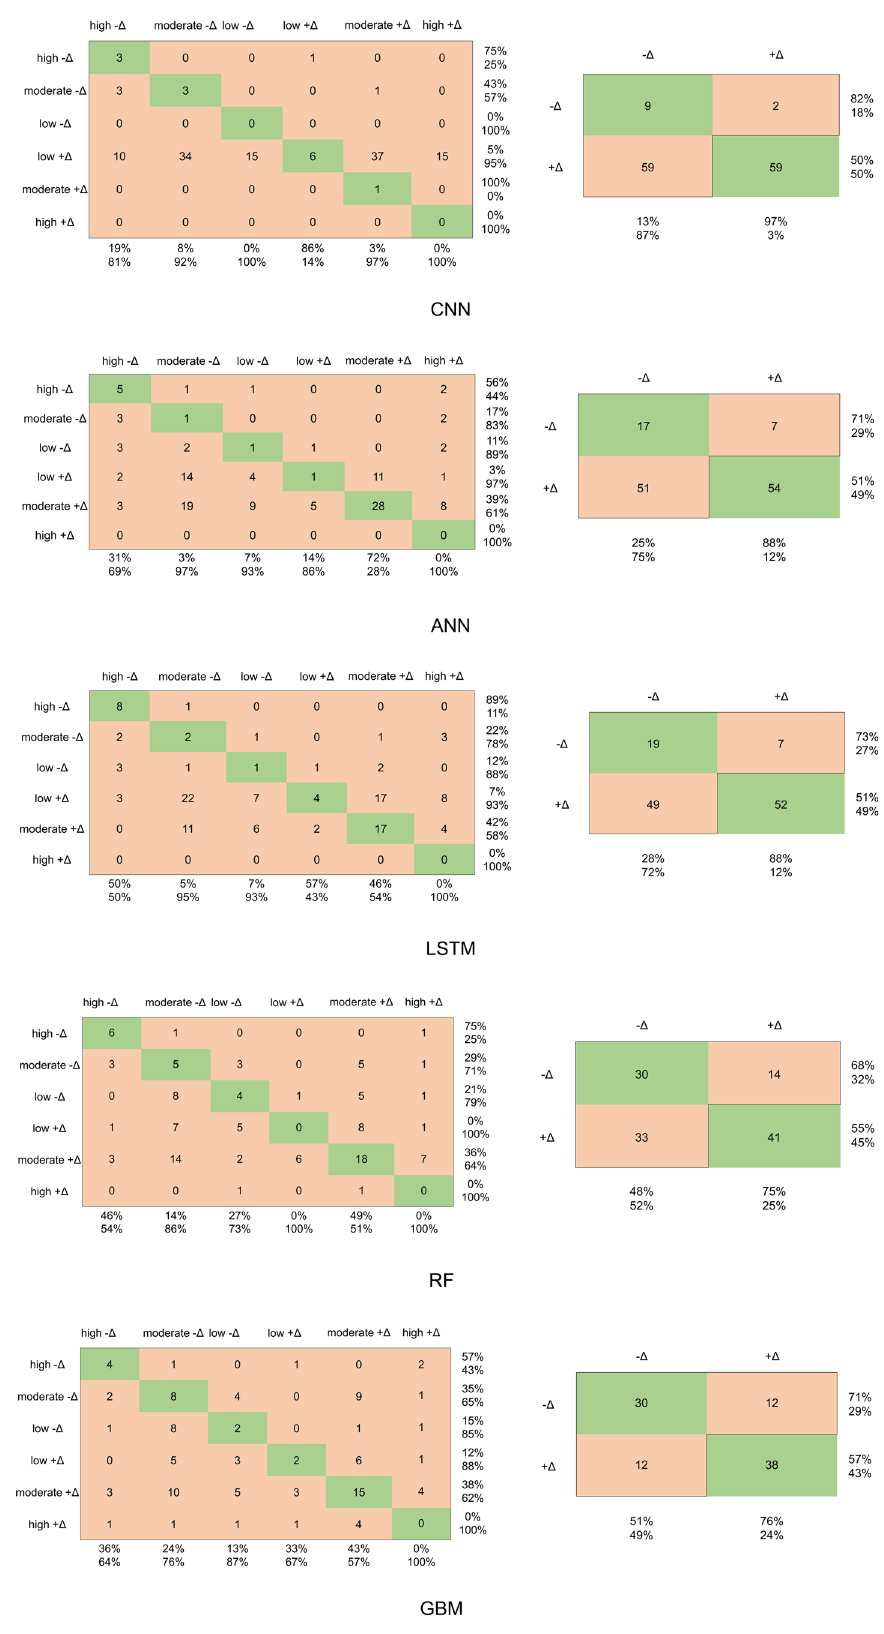
Fig. 12 Confusion matrix of left—scenario 1 (binary class) and right—scenario 2 (multi- class) for regression-based streamflow